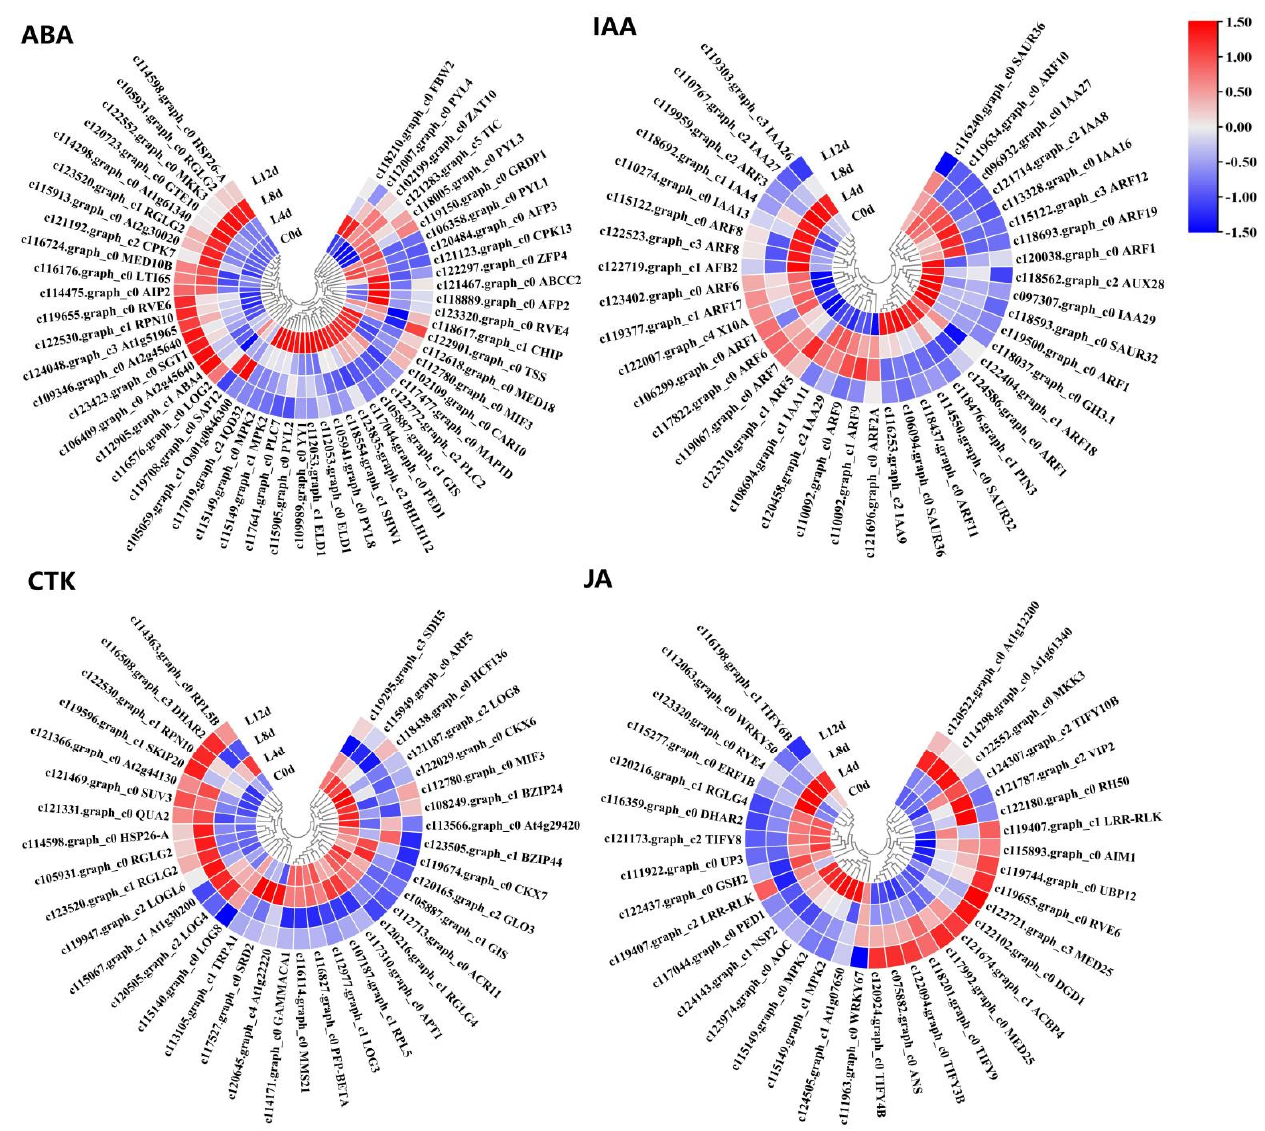
Figure 6. Heat map diagram showing the expression profiles of the ABA ‐ , IAA ‐ , CTK ‐ , and JA ‐ DEGs under low ‐ temperature conditions. ‘Huaizhi’ litchi trees were grown in a chamber with 22 °C/17 °C (day/night temperature, 12 h day and 12 h night) as the normal temperature. Temperatures dropped from the normal one to 2 °C for 4 d, and then were maintained at 2 °C for another 8 d. C0d, L4d, L8d, and L12d mean the leaves samples at 0 d, 4 d, 8 d, and 12 d of treatment. Fragments per kilobase of transcript per million mapped reads (FPKM) values were normalized to Z ‐ score.